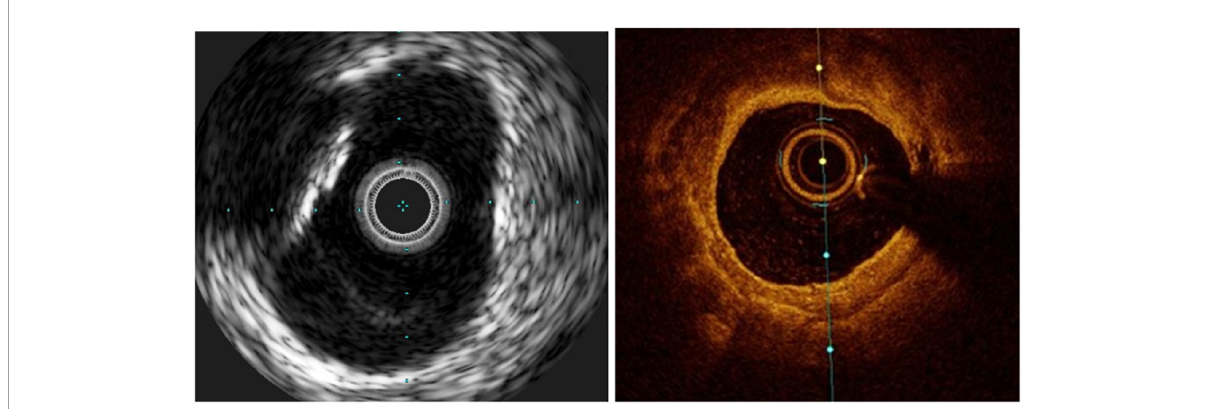
FIGURE3 Calcific lesions at intravascular ultrasound (Left) and optical coherence tomography (Right) . The limitation of IVUS in this case is that the lesion projects a shadow that does not allow measuring its